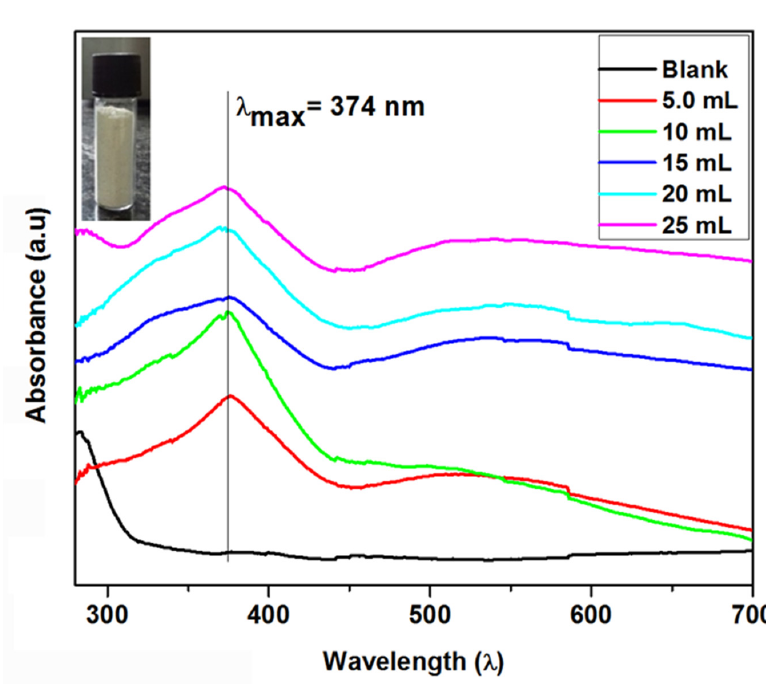
Figure 1. Optical spectra (UV-Vis) of colloidal zinc oxide (ZnO) nanoparticles (NPs) synthesized using Cassia fistula fruit extract (inset—camera photo of the synthesized ZnO NPs).